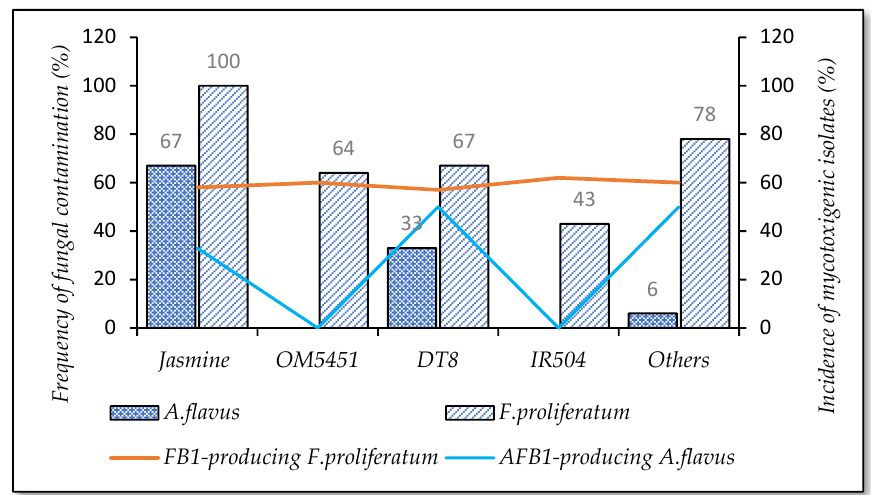
Figure 6. Incidence of fungal contamination and mycotoxigenic fungi in different paddy lines.